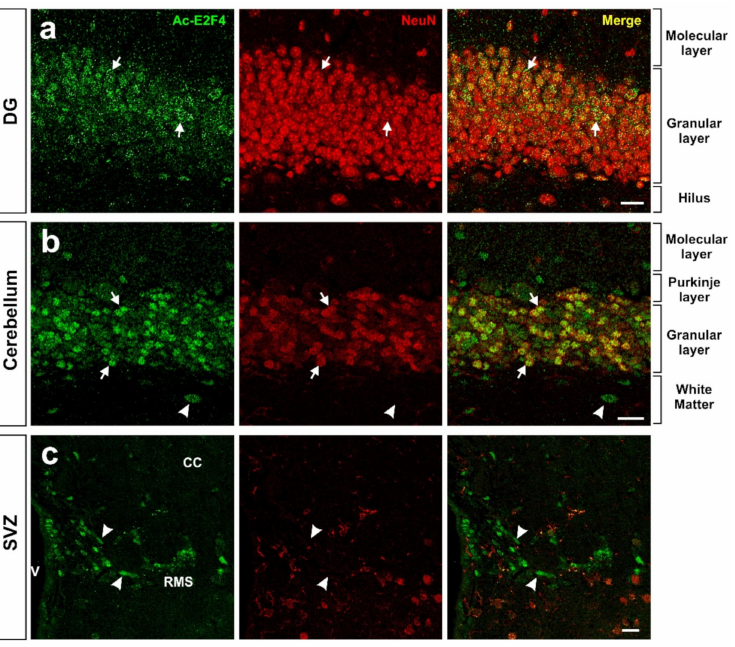
Figure 2. Expression pattern of acetylated E2F4 in the dentate gyrus (DG) ( a ), cerebellum ( b ), and subventricular zone (SVZ) ( c ) of 2.5-month-old WT mice. One single confocal plane showing co- immunostaining with anti-acetylated E2F4 (Ac-E2F4) and anti-NeuN (NeuN) antibodies in sections from the indicated brain areas. NeuN specifically labels neurons. Ac-E2F4 immunostaining in NeuN- positive (arrows) and NeuN-negative (arrowheads) cells is shown. V: ventricle; CC: corpus callosum; RMS: rostral migratory stream. Scale bar: 20 µ